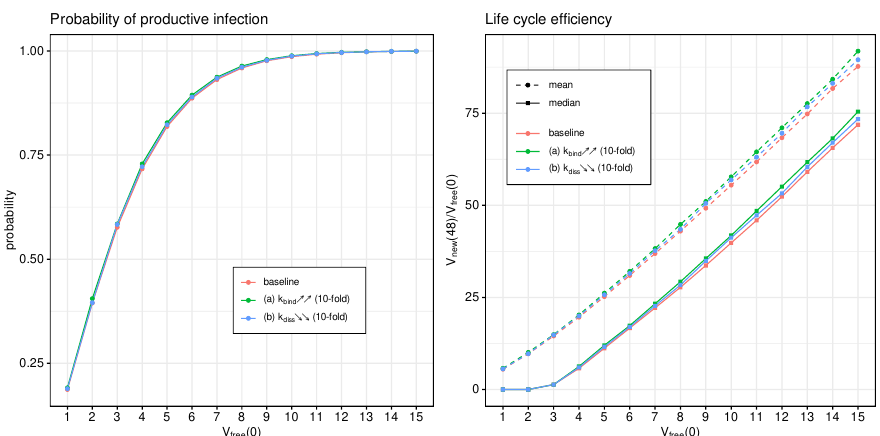
Figure 10. Effect of binding of SARS-CoV-2 to ACE2 on the probability of non-degenerate infection ( left ) and the efficient reproduction number ( right ) for MOI ranging from 1 to 15. The ascend- ing/descending arrows in the legend show the 10-fold increase/decrease in the indicated